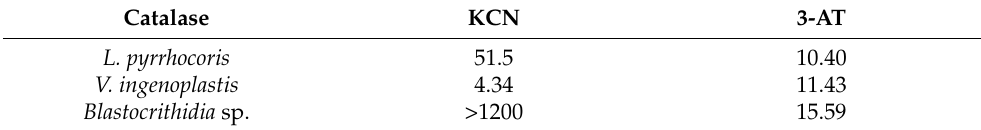
Table 2. KCN and 3-AT IC 50 values for trypanosomatid catalases (in µ M and mM,